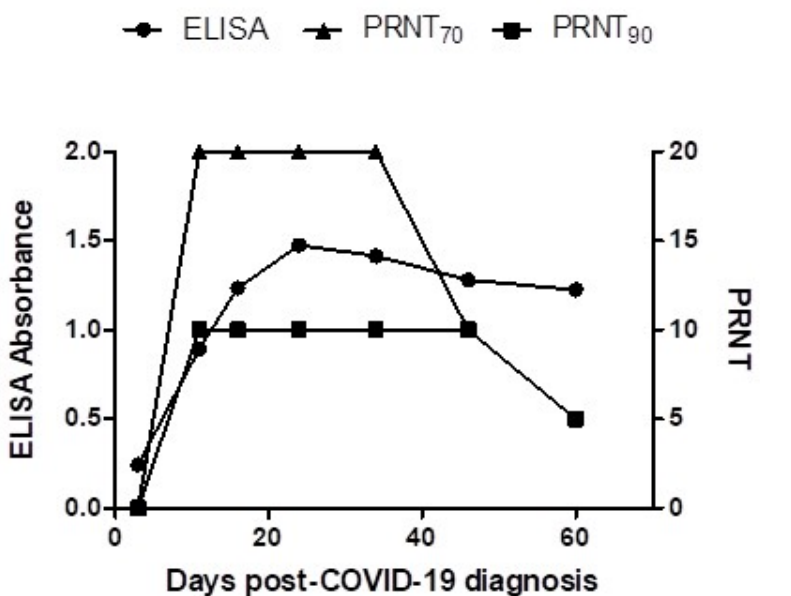
Figure 1. Antibody kinetics to SARS-CoV-2 in an 8-year-old Quarter horse following possible spillover infection from a COVID-19 individual. Antibodies were measured using an ELISA (circles), the PRNT 70 (triangles), and the PRNT 90 (squares).